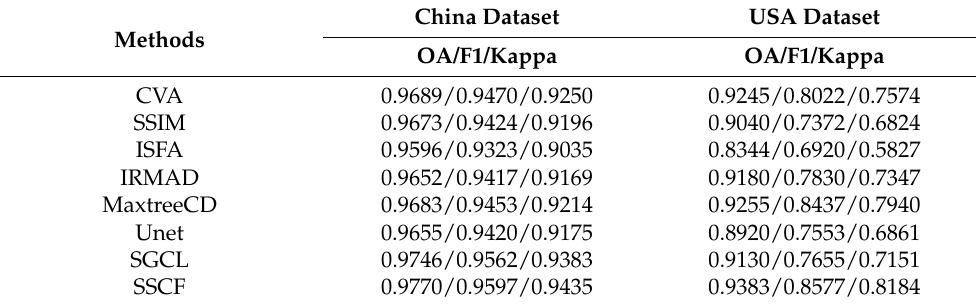
Table 2. OA, F1, and Kappa of all methods.